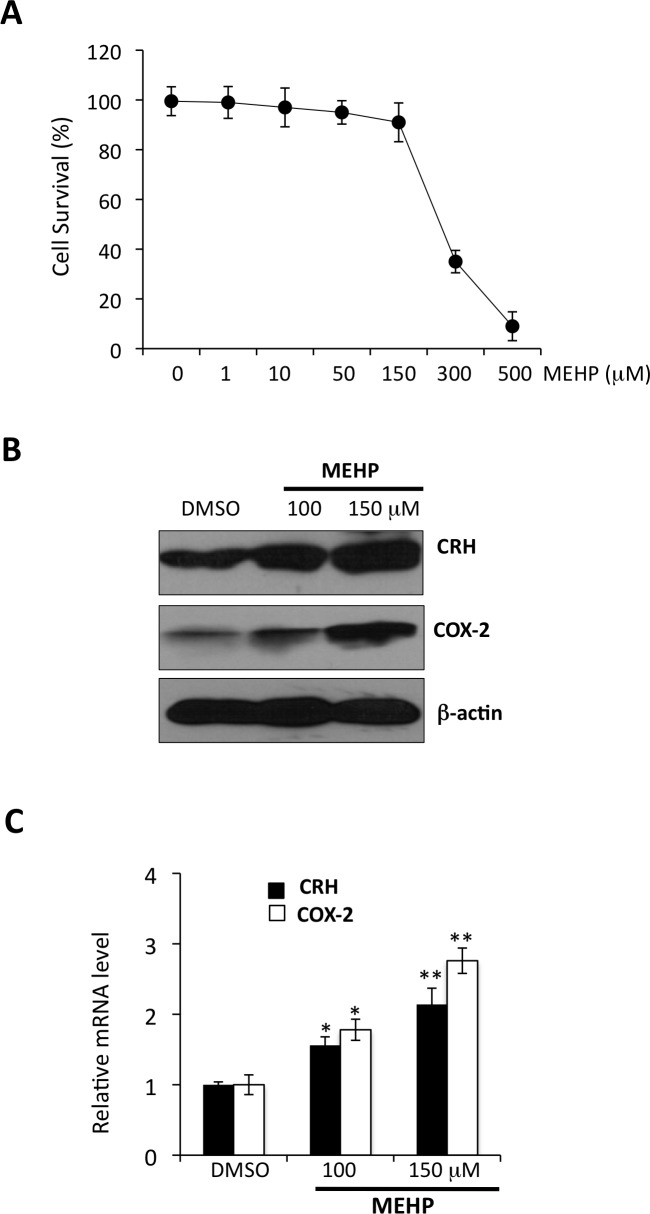
MEHP upregulates expression of CRH and COX-2 in primary cultures of human cytotrophoblast.Primary cultures of term cytotrophoblast were exposed to different concentrations of MEHP for 24 hours with DMSO as the vehicle control. (A) Trypan blue exclusion test of cell viability for primary cytototrophoblast exposed to MEHP at concentrations as indicated (N = 3 independent experiments). (B) Representative gel patterns and analysis in whole cell lysates from three independent term placentas by Western blot assay with use of antibody as indicated. (C) Total RNAs were extracted and RT-qPCR was performed for assessment of CRH and COX-2 mRNA levels with normalization to GAPDH mRNA level. Bars represent the average of relative mRNA levels and error bars represent standard deviation from experiments performed in three independent term placentas. * p < 0.05; ** p < 0.01.